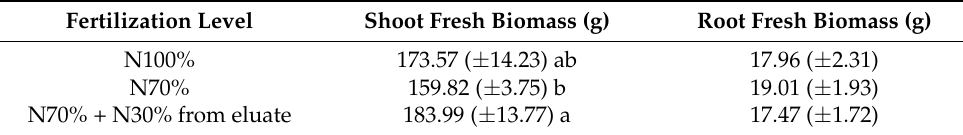
Table 2. Lettuce shoots and roots fresh biomass. The addition of the eluate to the fertigation plan improved the weight of lettuce plants, while it reduced the weight of roots. A reduced N supply reduced the shoot biomass and increased root weight. Values ±95% confidence interval are expressed in g. Different letters differ significantly (P < 0.05, Duncan test).